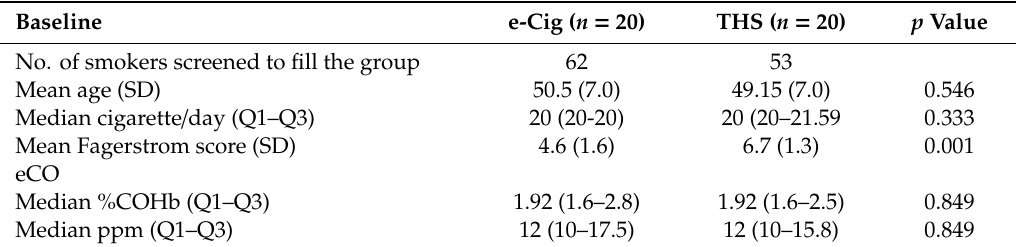
Table 1. Baseline data (Q1 = quartile 1; Q3 = quartile 3).